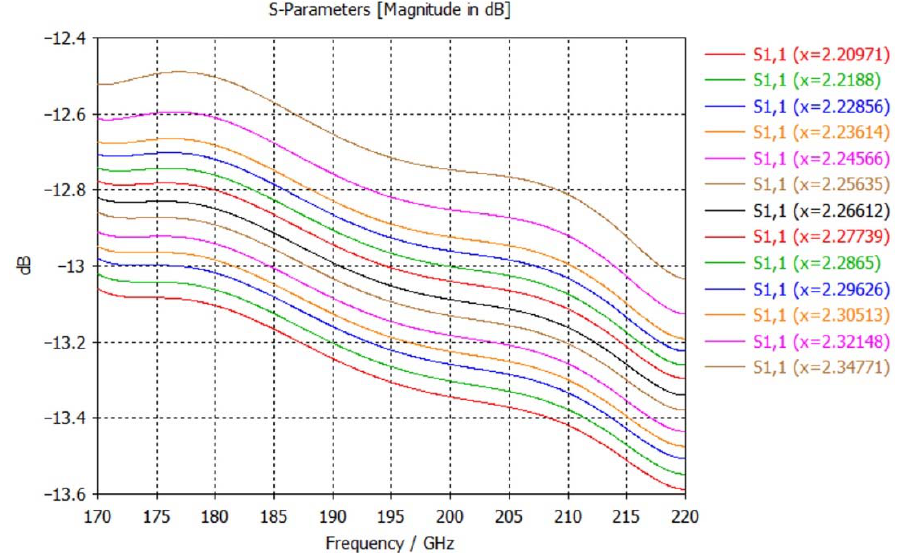
Figure 9. THz input return loss S11 change curve.